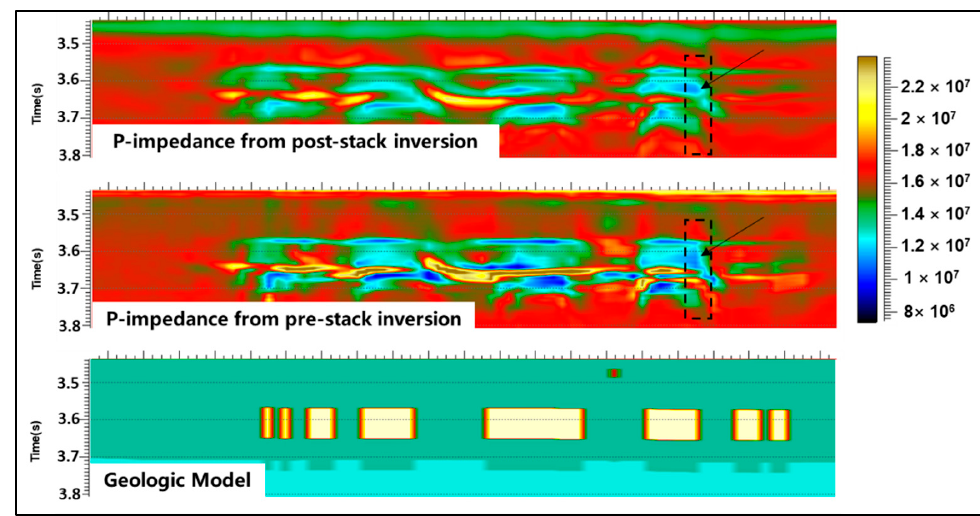
Figure 9. Comparison of P-impedance between post-stack inversion and pre-stack inversion: The black square shows the boundary of one of the caves clearly in the complicated combination; the post-stack inversion result has a lower resolution. Table 3. Quantitative analysis results of pre-stack